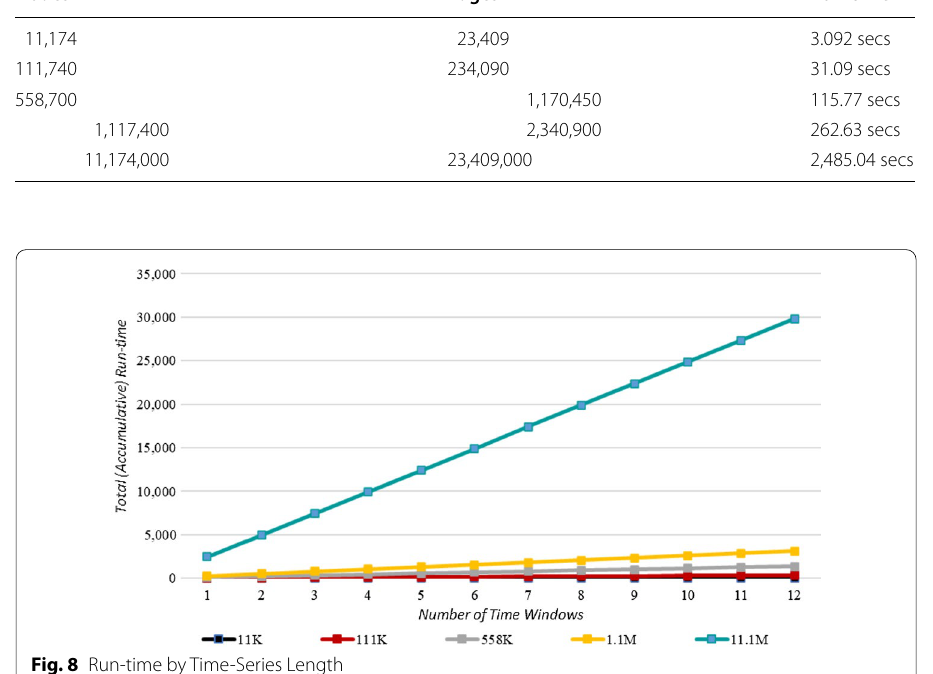
Fig. 8 Run-time by Time-Series